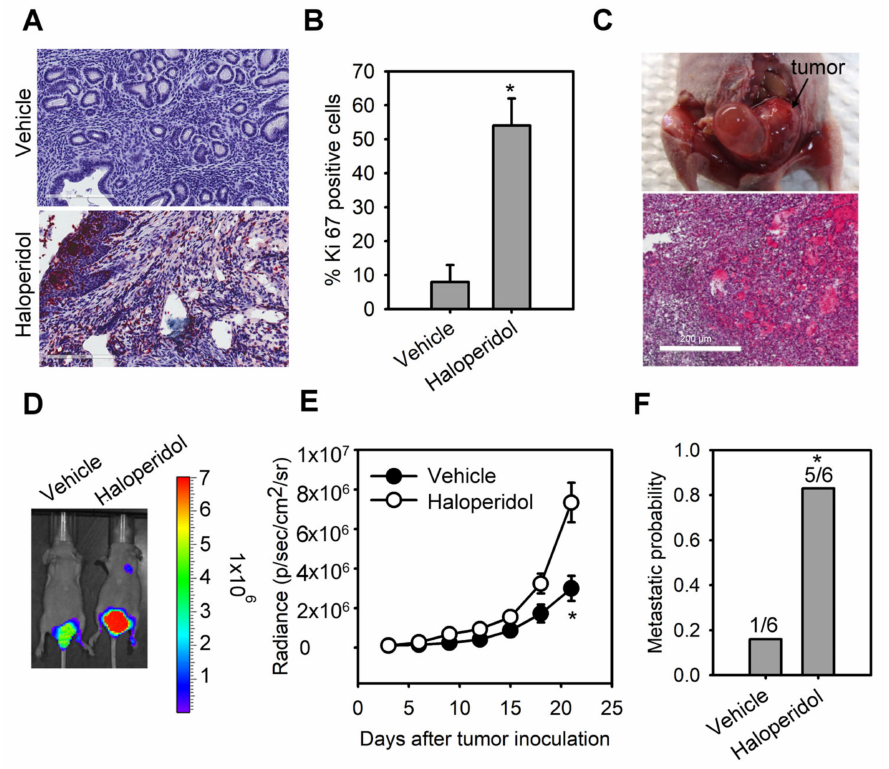
Figure 1. Haloperidol promotes endometrial hyperplasia and malignant progression of endometrial cancer (EC) in vivo. Ki-67 immunohistochemistry ( A ) and its quantification ( B ) in uterine tissues from adult C57BL/6J mice receiving the chronic treatment of haloperidol (2 mg/kg/day for 28 days). Bar = 200 µ m. ( C ) Representative images of an orthotopic xenograft model of HEC1A-lucGFP devel- oped in the uterus from athymic nude mice and its H&E staining. Bar = 500 µ m. ( D ) Bioluminescent images of HEC1A-lucGFP orthotopic xenografts with or without the chronic treatment of haloperidol (2 mg/kg/day for 21 days) on day 21 after tumor inoculation. ( E ) Longitudinal monitoring of the tumor growth via BLI signal intensities for each treatment group in ( D ). ( F ) The metastatic probability for each treatment group in ( D ). Data are presented as means ± SD (n = 6). * p < 0.01 compared to the untreated or vehicle group (normal